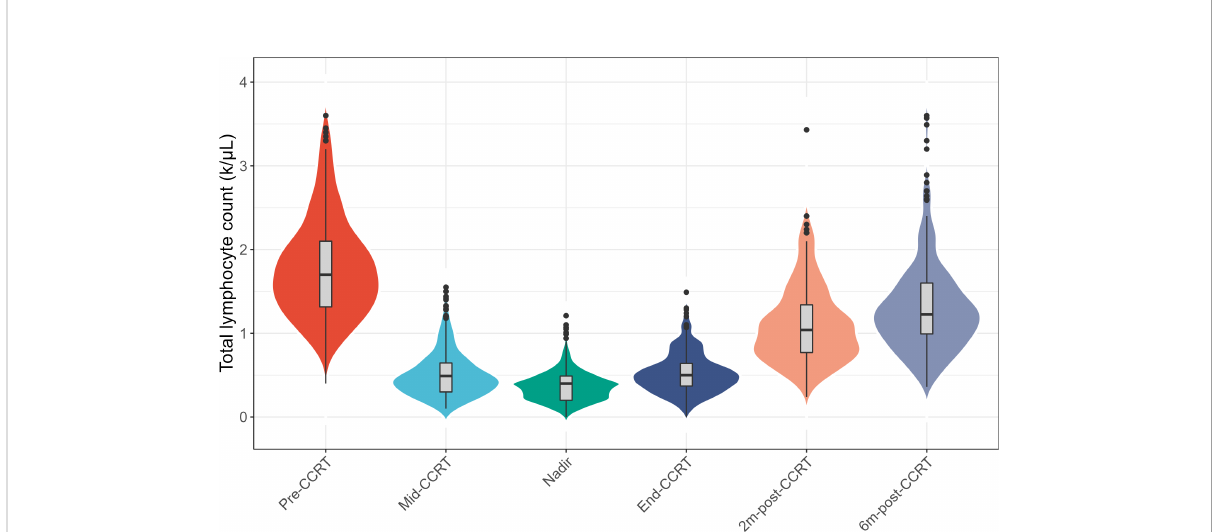
FIGURE 1 Changes of the total lymphocyte count (TLC) at longitudinal timepoints during concurrent chemoradiotherapy (CCRT) and follow-up. Abbreviations: pre-CCRT, the baseline; mid-CCRT, the 3 weeks during CCRT; end-CCRT, the end of CCRT; 2m-post-CCRT, 2 months after CCRT; 6m-post-CCRT, 6 months after